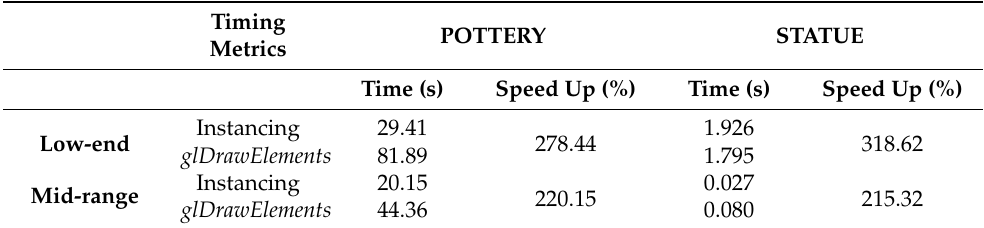
Table 10. Total time of drawing ten meshes on a simple 3D scene with the standard and instancing rendering methods along with the proportional speed up percentage achieved with